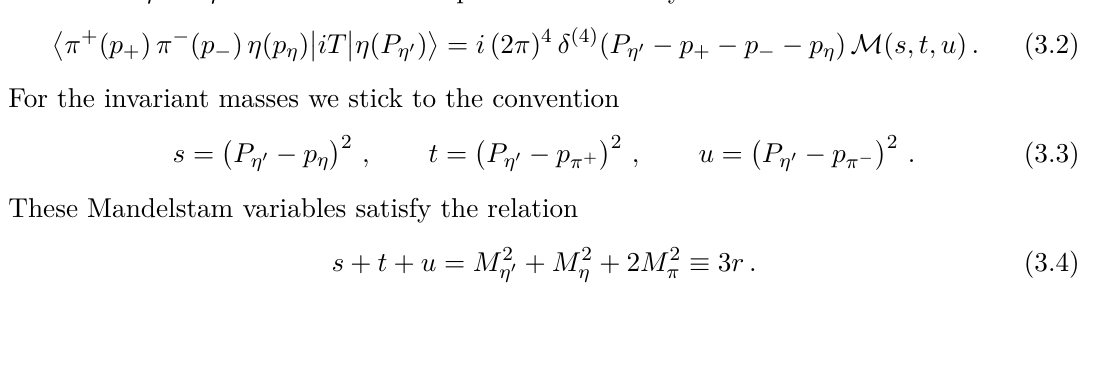
Figure 6 . Estimation for the distribution of the real (left) and imaginary (right) parts of M 6 C (top) and M 6 C (bottom) in η 0 → π + π − π 0 over the allowed phase space. As a rough estimation, 2 the normalizations of each amplitude are fixed by the central fit result obtained for η → π + π − π 0 in table 2. In contrast to figure 5 additional zero lines occur as a consequence of the interference with the ρ -resonance, which lies in the kinematically accessible